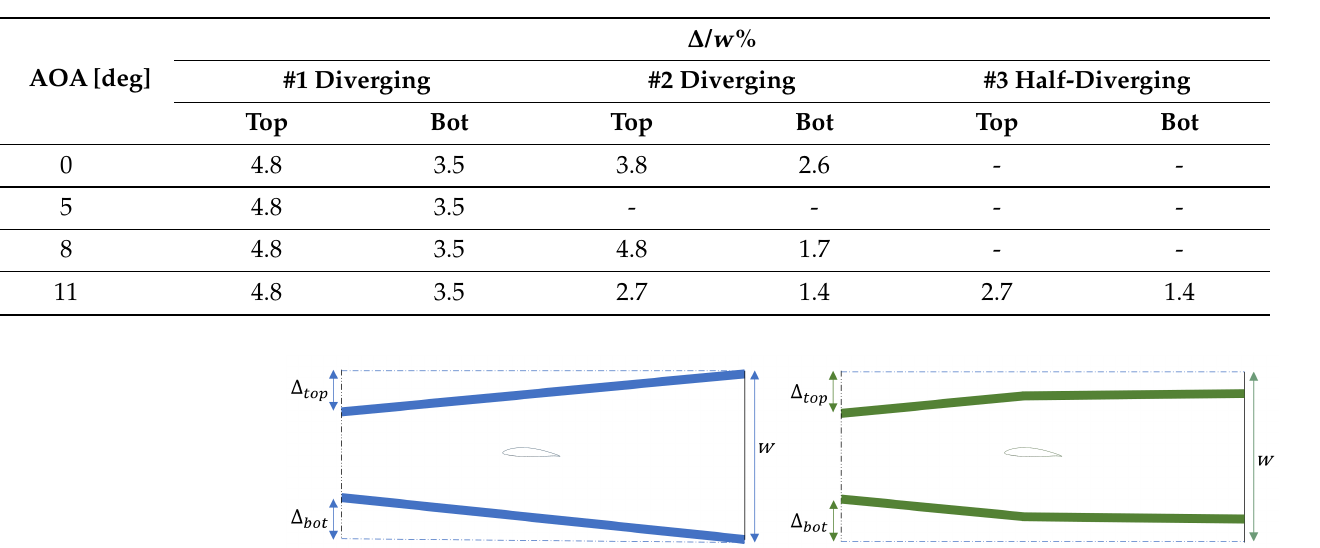
Table 2. Insert configuration for each study case: three different cases are considered. Sketches are shown in Figure 12, where #1 and #2 are according to Figure 12-left and #3 refers to Figure 12-right.